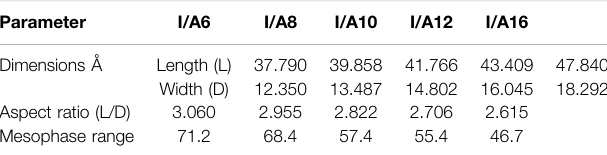
TABLE 2 | Dimensional parameters and aspect ratios of SMHBCs, I/An.